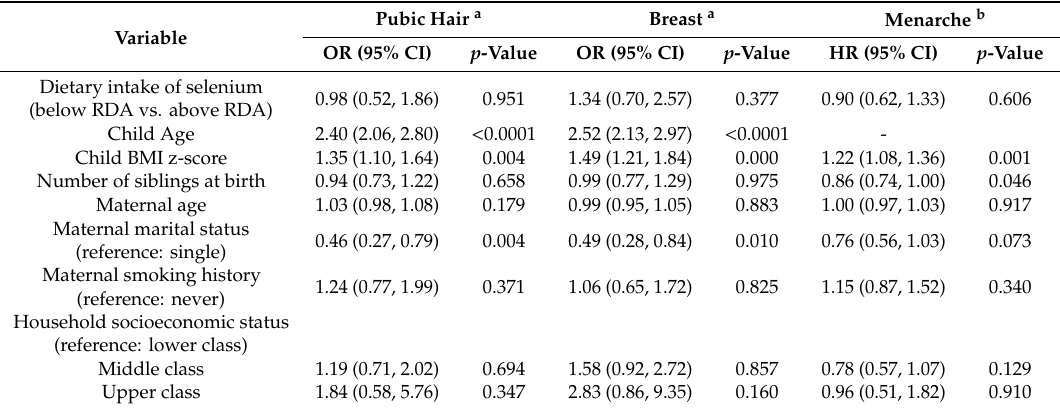
Table 3. Adjusted associations between dietary intake of selenium (below RDA vs. above RDA) and physician-assessed secondary sex characteristics in girls at age 10–18